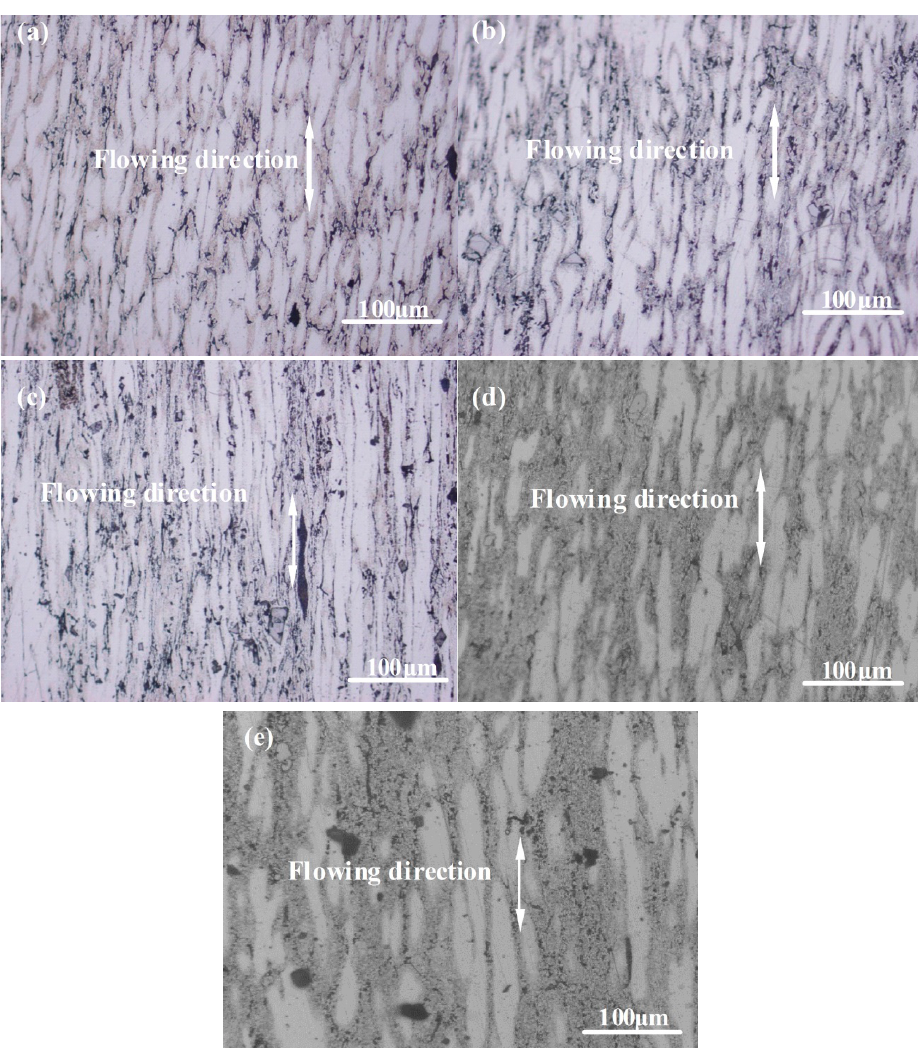
Figure 9. OM microstructure of the thixoformed part soaked for different times at 600 °C: ( a ) 5 min,